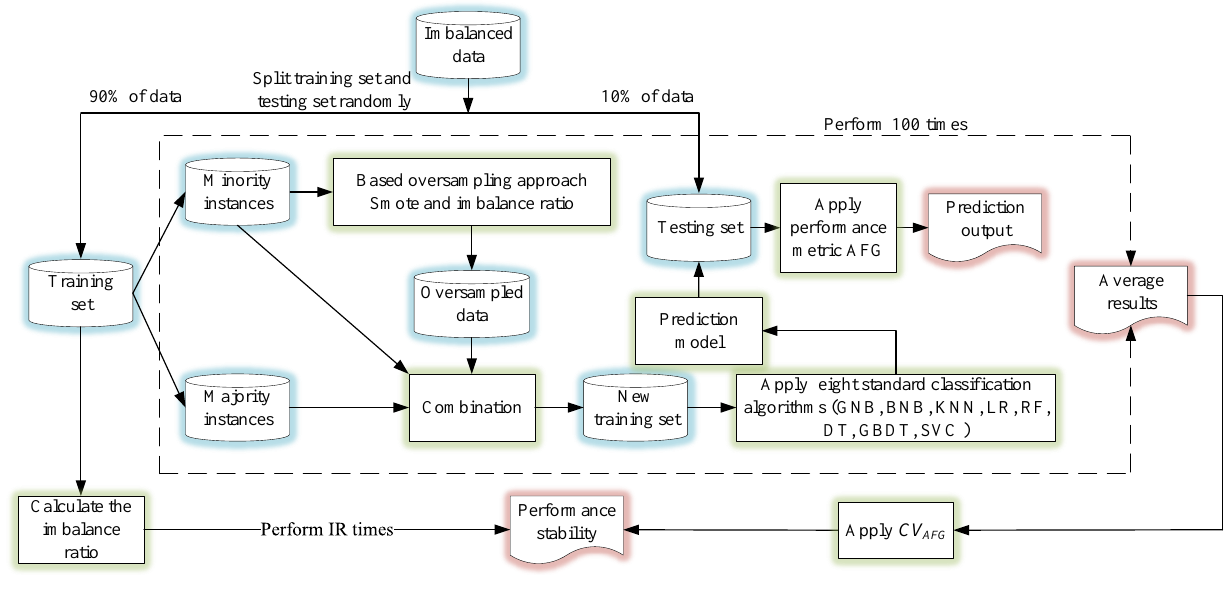
Figure 6. Experimental